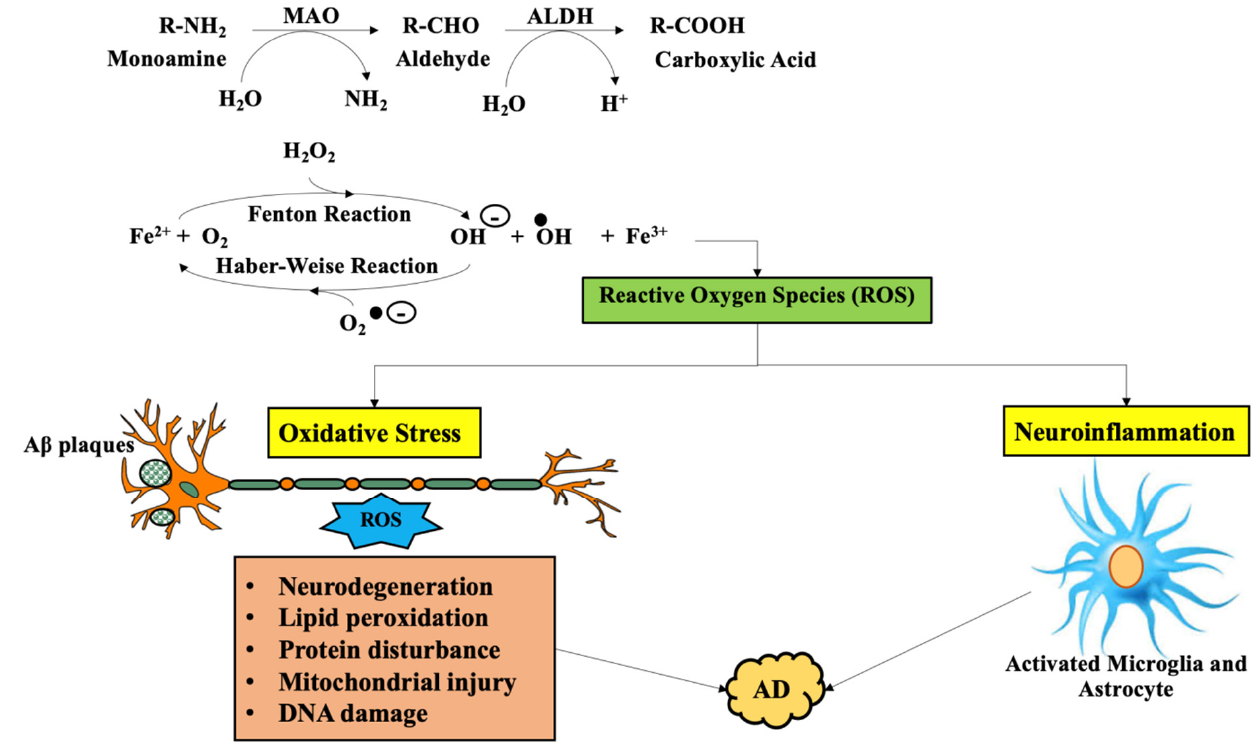
Figure 3. The reactive oxygen species generated by overactive monoamine oxidase in conjunction with Fenton’s and Haber-Weise reaction which successively causes neuroinflammation and oxidative stress; implicated in Alzheimer’s disease (AD). Legend: MAO—monoamine oxidase; ALDH—aldehyde dehydrogenase; NAD + —nicotinamide adenine dinucleotide; NADH—reduced nicotinamide adenine dinucleotide; H 2 O 2 —hydrogen peroxide; O 2 —singlet oxygen; ROS—reactive oxygen species; Fe 2+ —ferric ion; AD–Alzheimer’s disease.